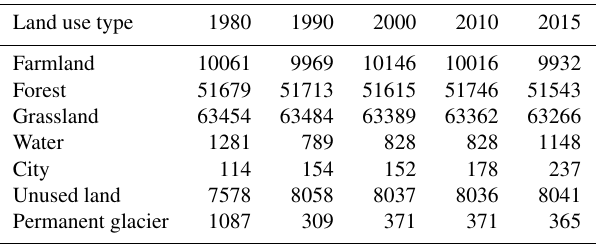
(Nation: permanent glacier in Table 5 is a second-level type which belongs to “Water”.)